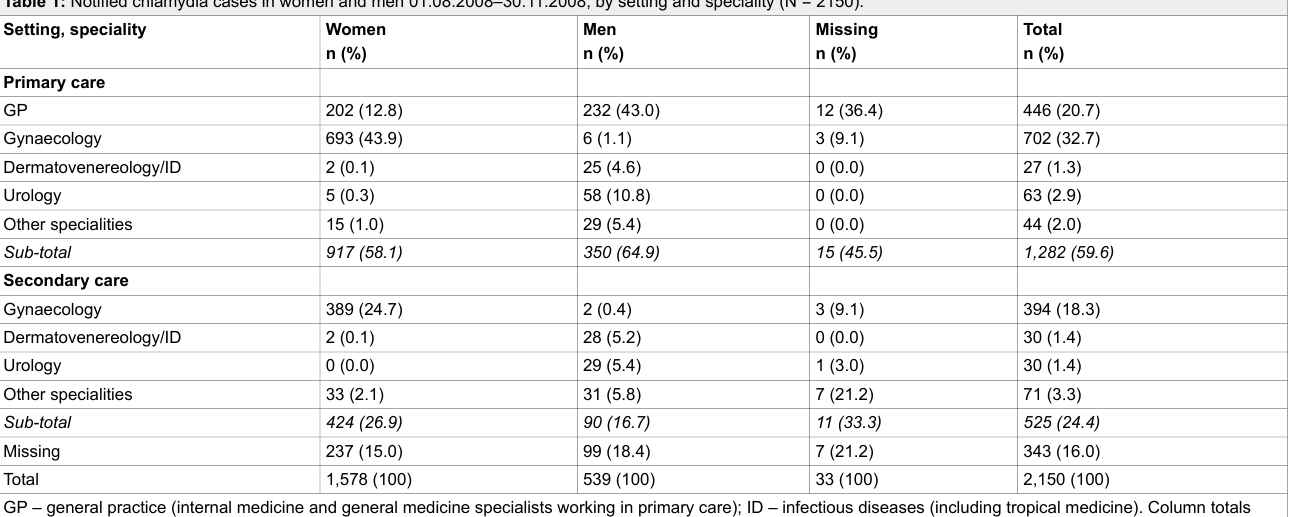
Table 1: Notified chlamydia cases in women and men 01.08.2008–30.11.2008, by setting and speciality (N = 2150). Setting, speciality